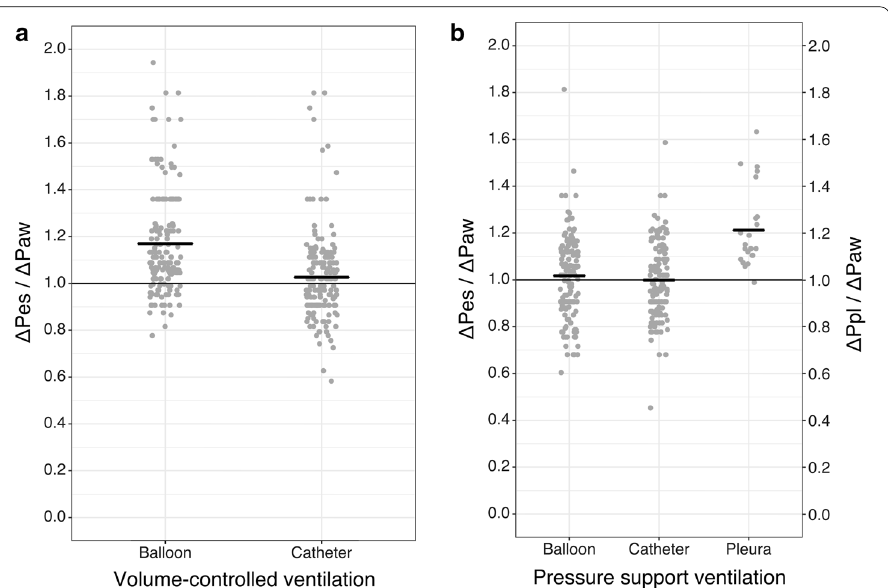
Fig. 2 Esophageal-to-airway pressure change ratios in controlled and assisted modes. Esophageal-to-airway pressure change ratios: a in volume-controlled mode, induced by external chest compressions during end-expiratory occlusion (dynamic positive pressure occlusion test), using both balloon (left) and catheter (right) method; b in assisted mode, induced by spontaneous inspiratory efforts against airway occlusion test (Baydur’s maneuver). For comparison in b , pleural-to-airway pressure change ratios obtained in patients with pleural pressure measurements. Black lines indicate means of